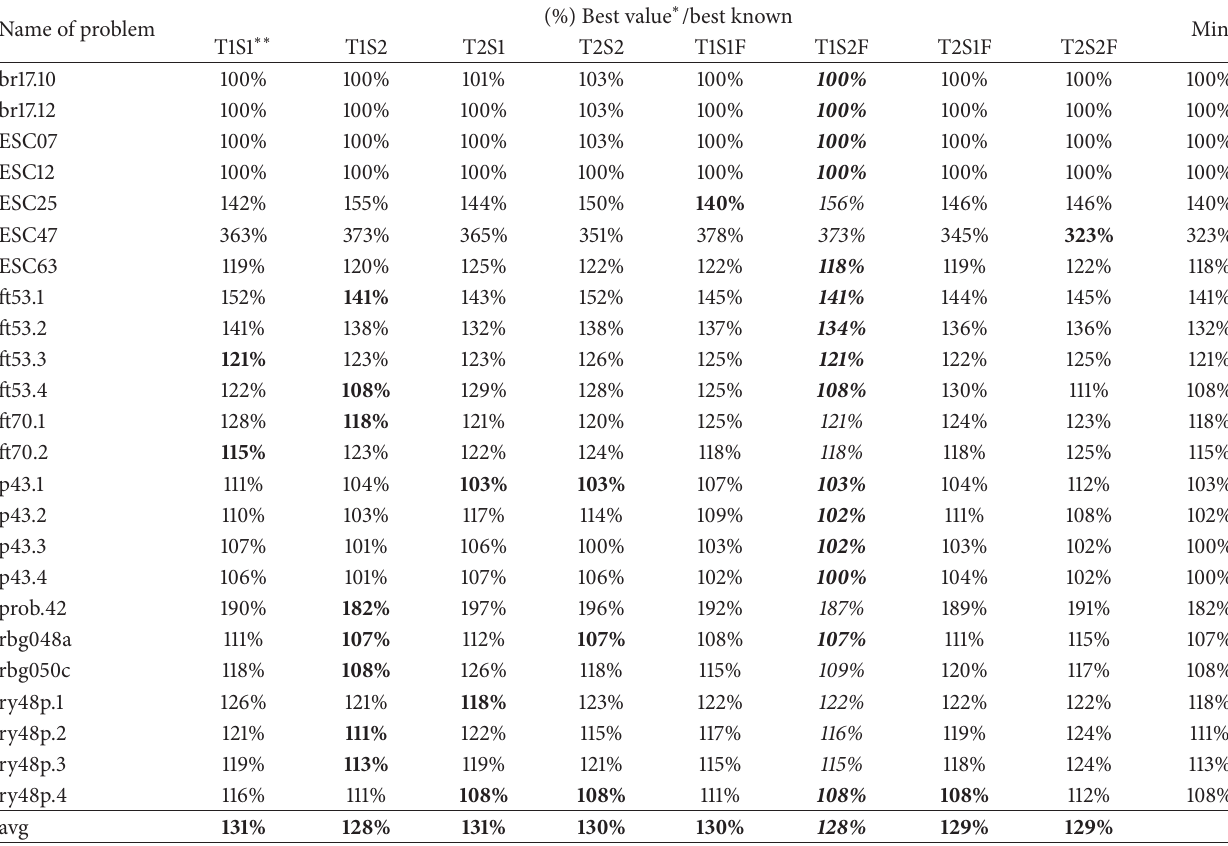
Table 5: Comparison against best known values with TSPLIB problem